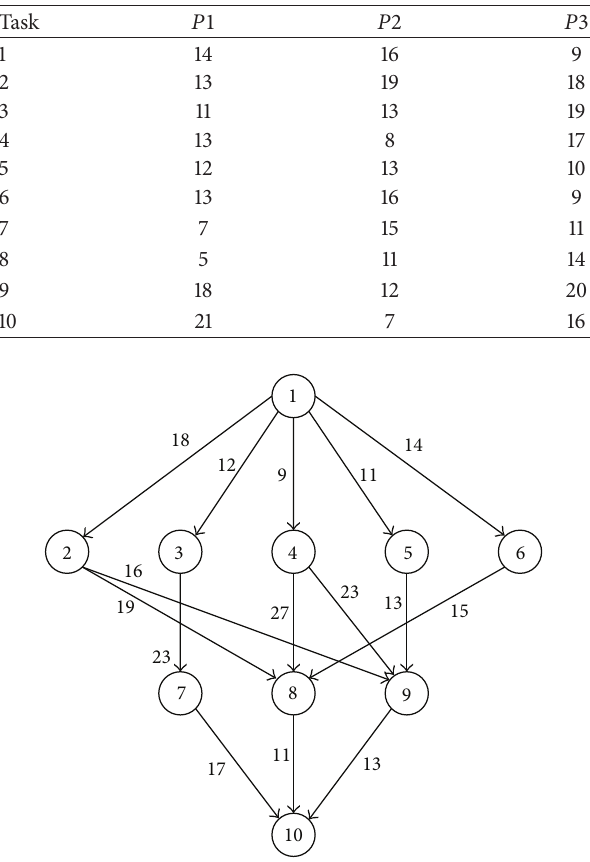
Figure 10: A DAG used for multiple iterations to find minimum 𝑚𝑎𝑘𝑒𝑠𝑝𝑎𝑛